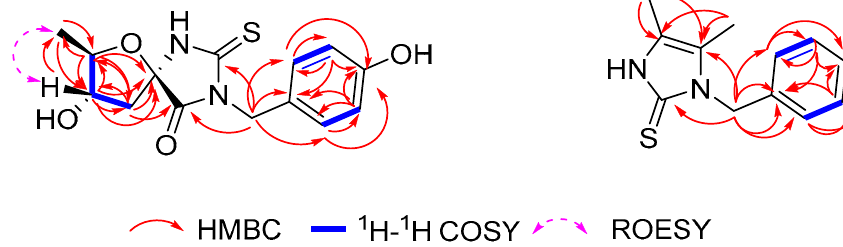
Figure 2. Key 2D NMR correlations of 1 and 2 .